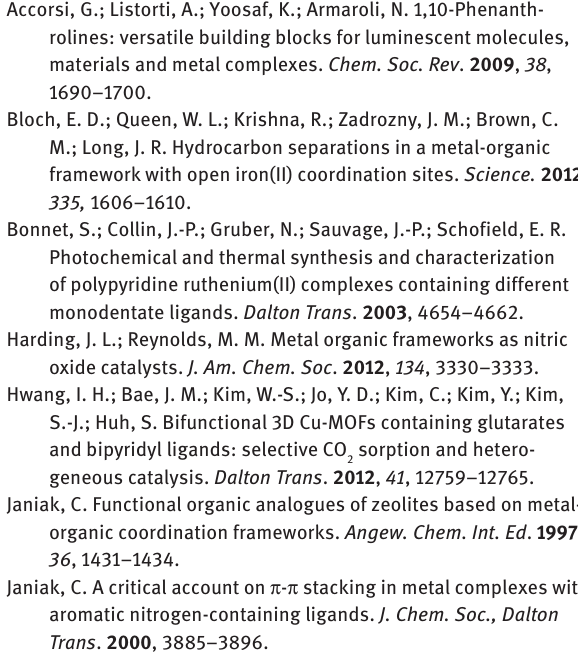
Table 1 . Detailed crystal data and structure refi nement are listed in Table 4 . Crystallographic data have been deposited with the Cam- bridge Crystallographic Centre as supplementary publication num- ber